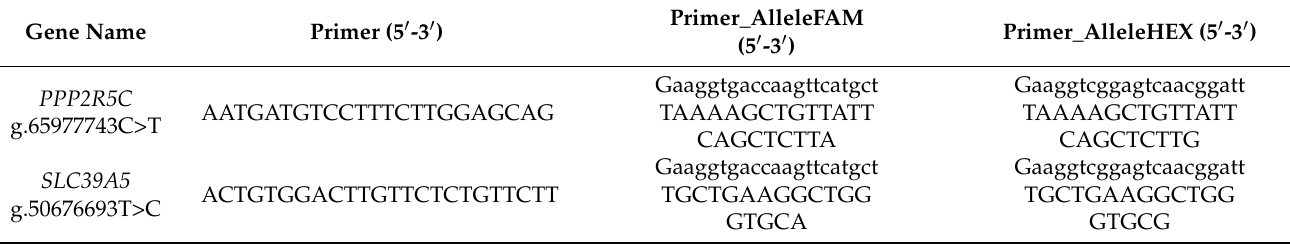
Table 3. Primer information for SNP